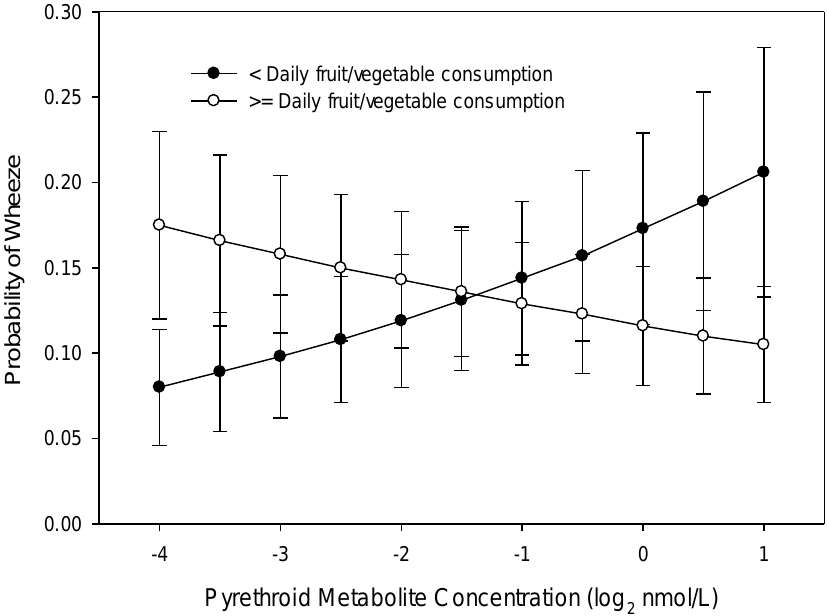
Figure 5. Probability of child wheeze at any age related to maternal pyrethroid (3-Phenoxybenzoic acid, 3PBA) metabolite concentration and maternal daily fruit and vegetable consumption during pregnancy ( n = 367).